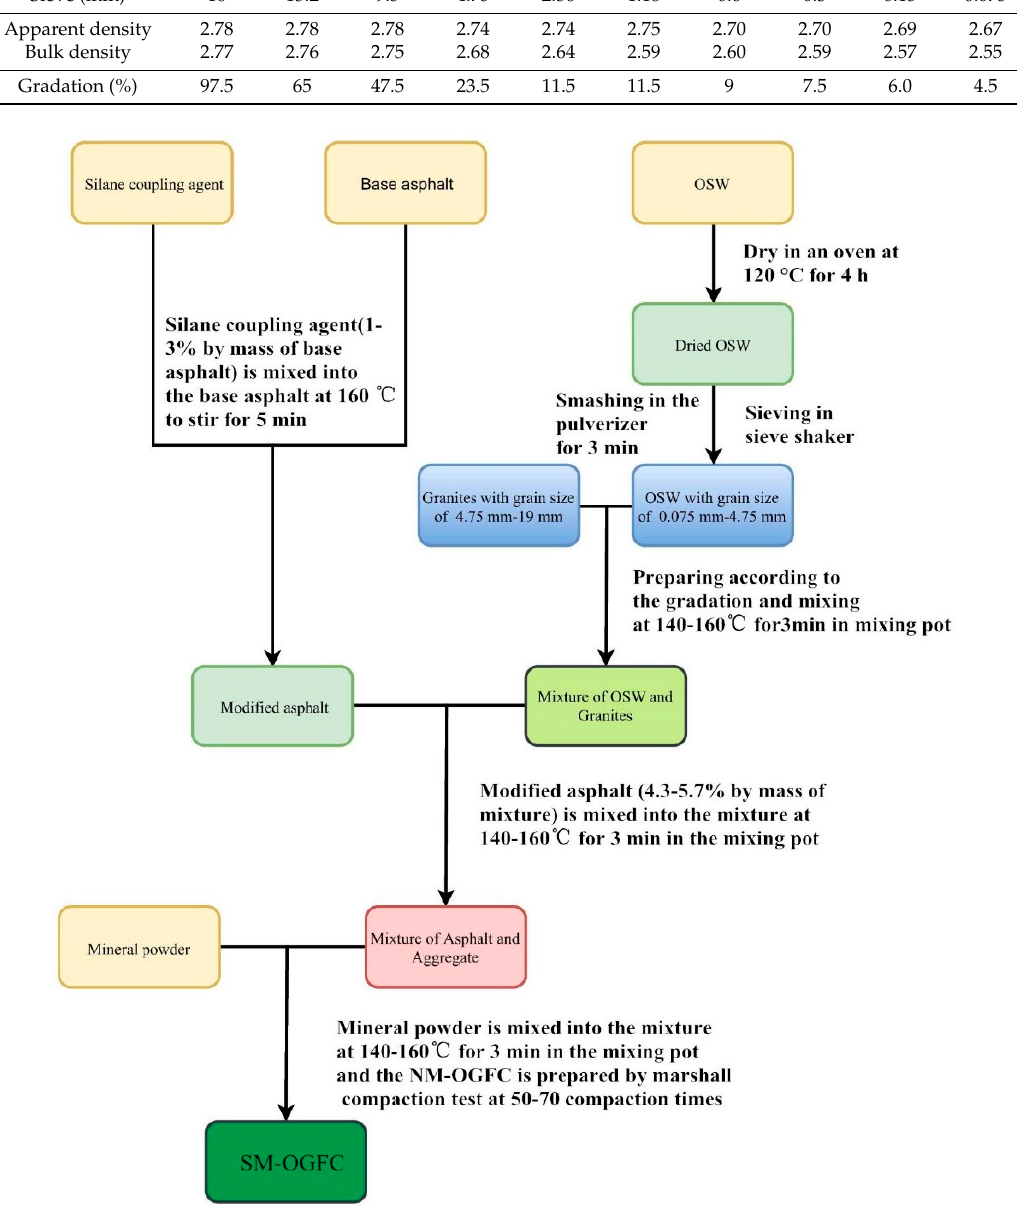
Figure 2. The flowchart of preparation of the SM-OGFC.